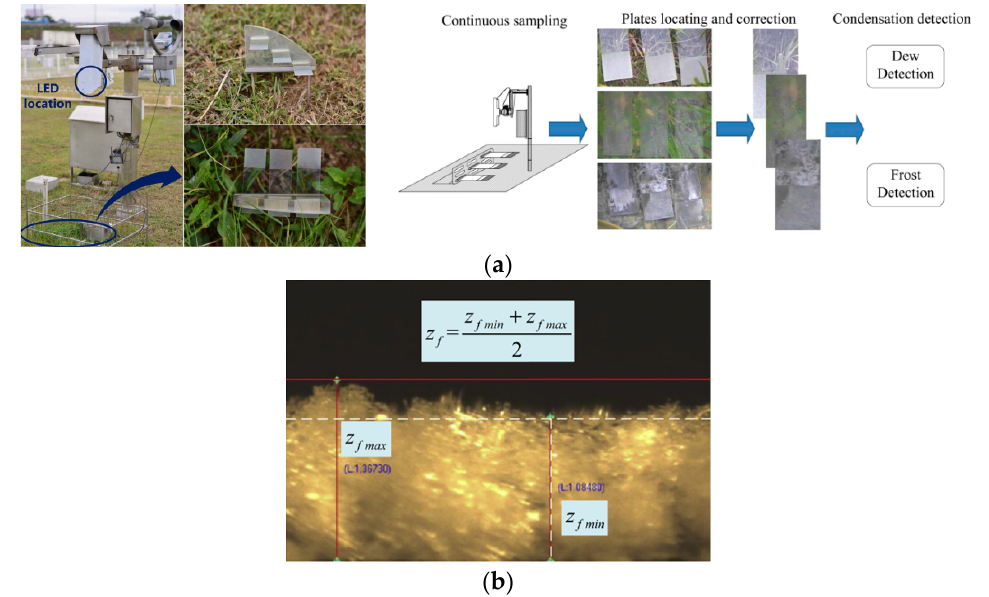
Figure 6. Machine vision detection method: ( a ) automatic frost observation equipment and treatment process based on a glass carrier; ( b ) using the image method to measure frost thickness ( Z f is the average thickness of frost, Z fmax is the average maximum thickness of frost, Z fmin is the average minimum thickness of frost) [48,66].